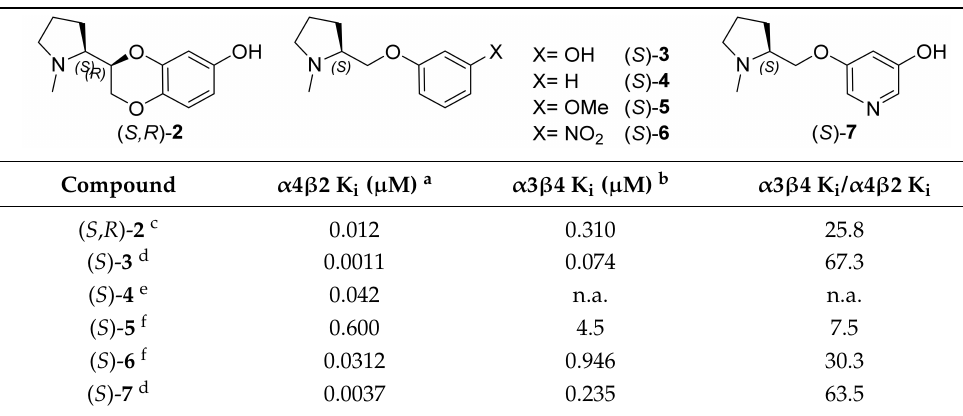
Table 1. Binding affinity data at α 4 β 2 and α 3 β 4 nAChRs and α 4 β 2 vs. α 3 β 4 selectivity ratio of compounds ( S , R )- 2 , ( S )- 3 – 7 reported in the literature. a Tested at rat cortex using [ 3 H]-epibatidine, unless otherwise specified. b Tested at membranes of human α 3 β 4 transfected cells. c Data